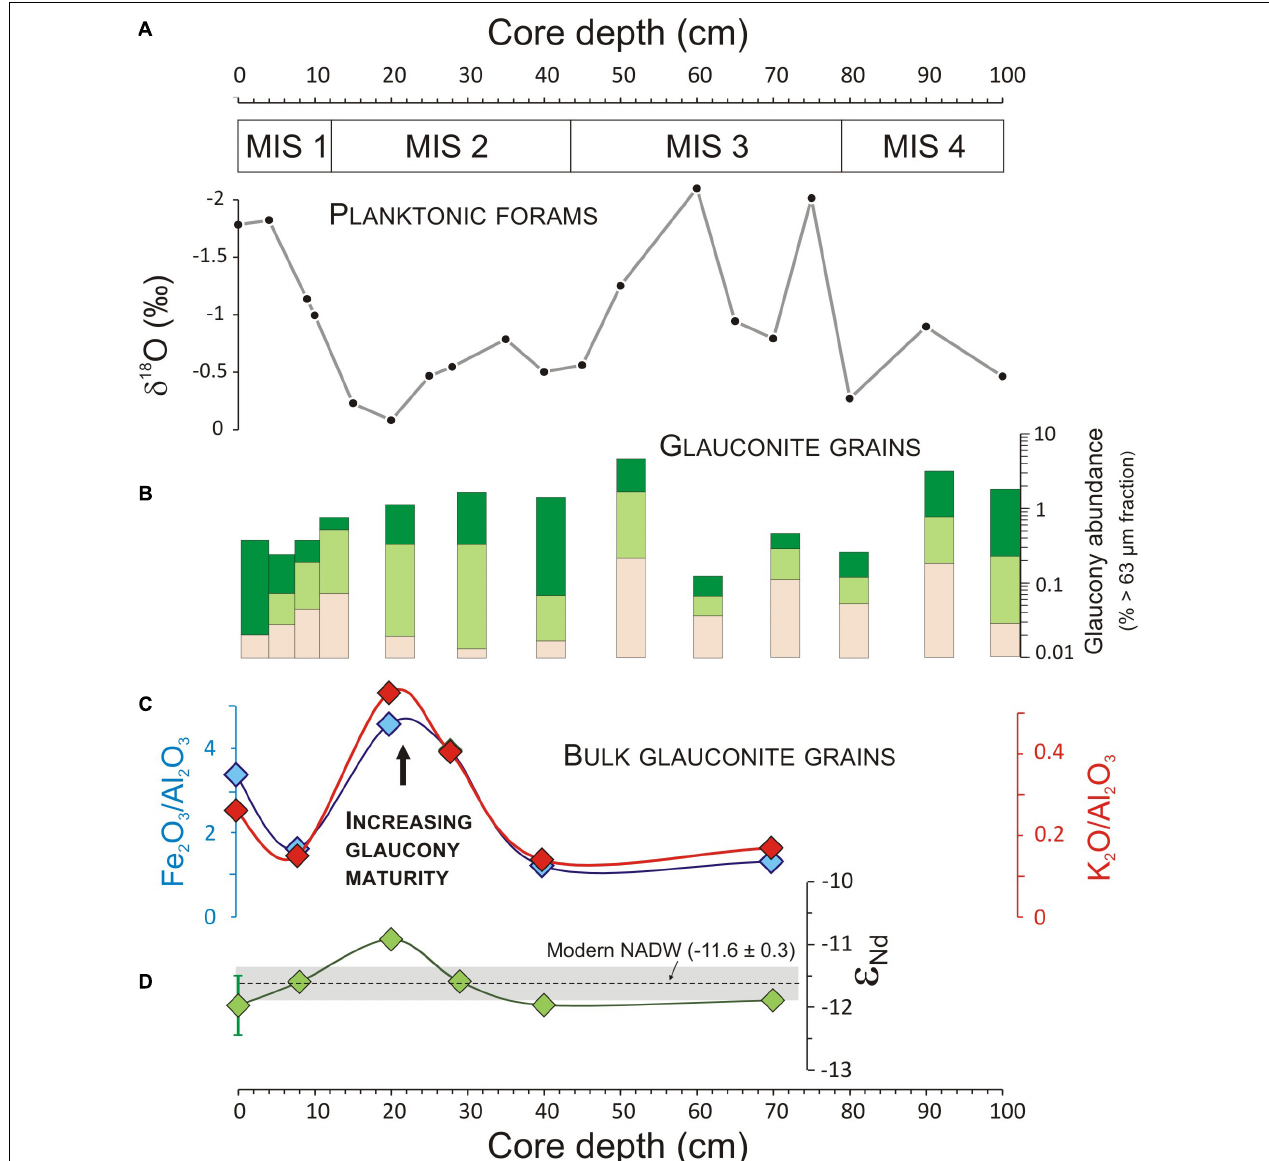
FIGURE 3 | (A) Planktonic foraminifer δ 18 O depth profile (Tallobre et al., 2019) and (B) relative abundance distribution of glauconitic grains in core IG-KSF-11 (Tallobre et al., 2019). The beige, light green, and dark green boxes correspond to increasing degrees of glauconitic maturity based on visual colour and number of cracks. (C) Bulk Fe 2 O 3 /Al 2 O 3 and K 2 O/Al 2 O 3 ratios of studied glauconite grains (this study), reflecting the degree of glauconitisation. (D) Nd isotopic composition ( ε Nd ) of bulk glauconite grains. The dotted line and associated grey band indicates the present-day ε Nd value of ambient bottom-waters at the same water depth (Huang et al., 2014). Note that the uncertainty on measured ε Nd values ( ± 0.15; 2 SD) is smaller than symbol size, unless reported (sample 0_1